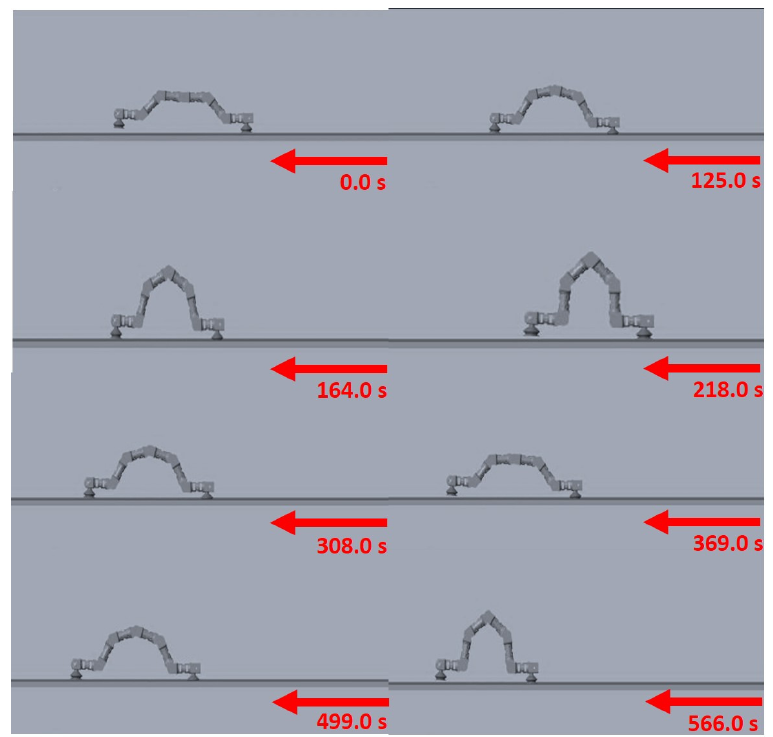
Figure 10. Sequence of movements of the gait cycle of the WBRD in